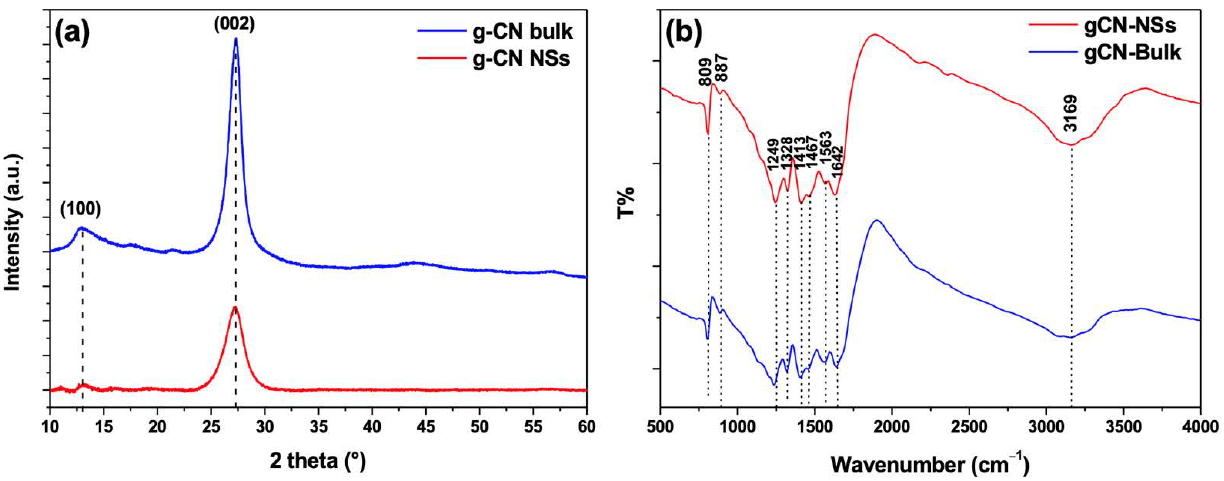
Figure 4. ( a ) X-ray diffraction diagram and ( b ) FTIR spectra of gCN bulk and